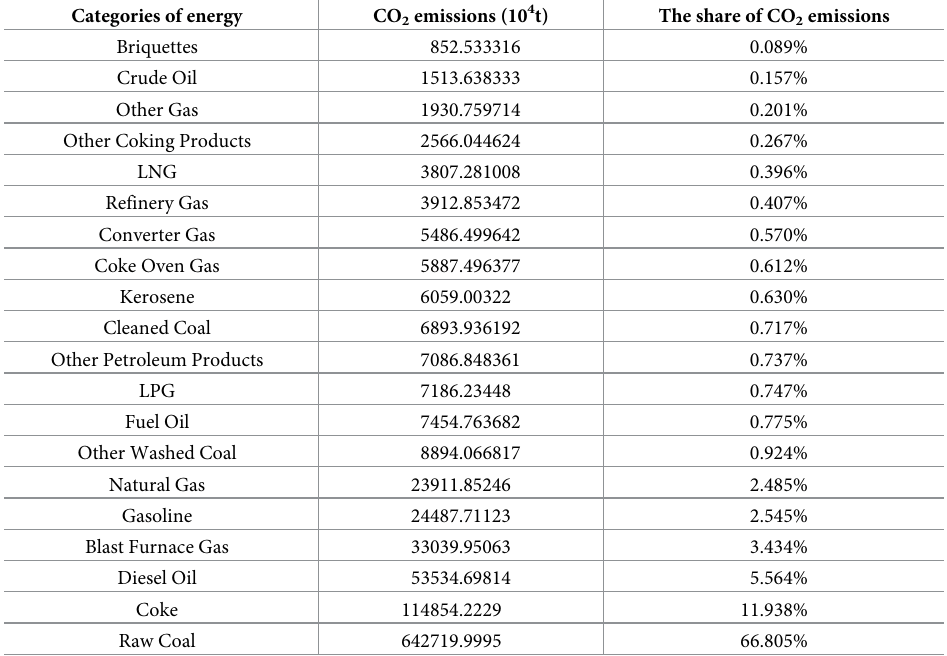
Table 3. The CO2 emission from different energy sources.